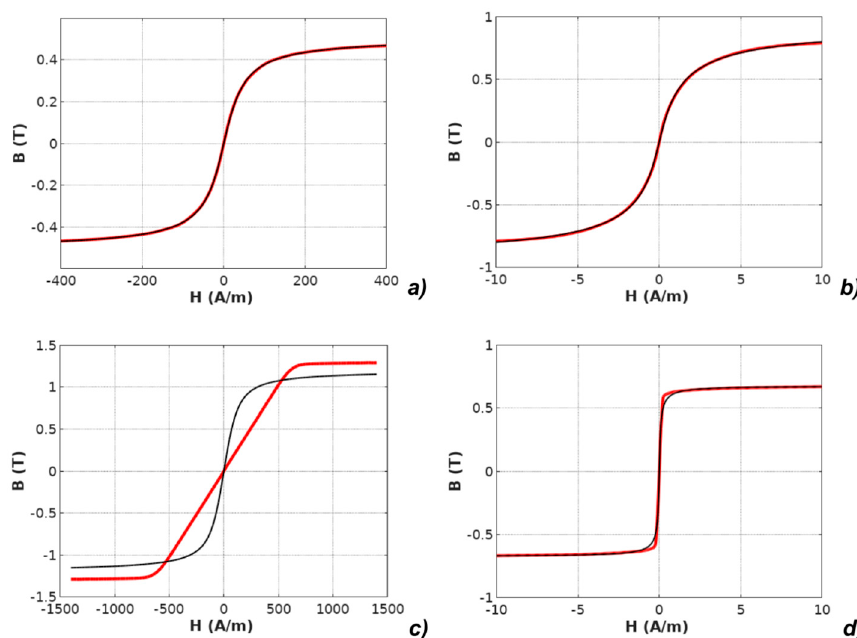
Figure 6. Results of modeling the anhysteretic curve using the isotropic Langevin function (measurements: red line, modeling: black line): ( a ) Mn-Zn ferrite F3001, ( b ) Co 67 Fe 4 Mo 1 B 11 Si 17 amorphous alloy, ( c ) Fe 73.5 Cu 1 Nb 3 Si 15.5 B 7 nanocrystalline alloy with perpendicular anisotropy, ( d ) Fe 67 Co 18 B 14 Si 1 amorphous alloy with parallel anisotropy